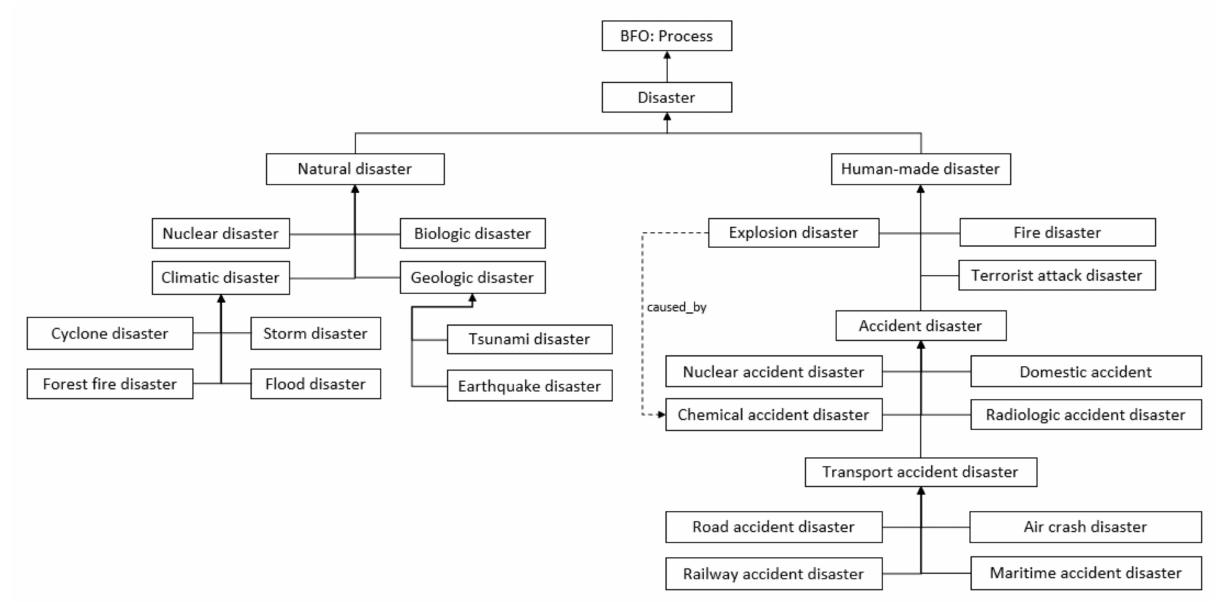
Figure 7. Disasters classification in